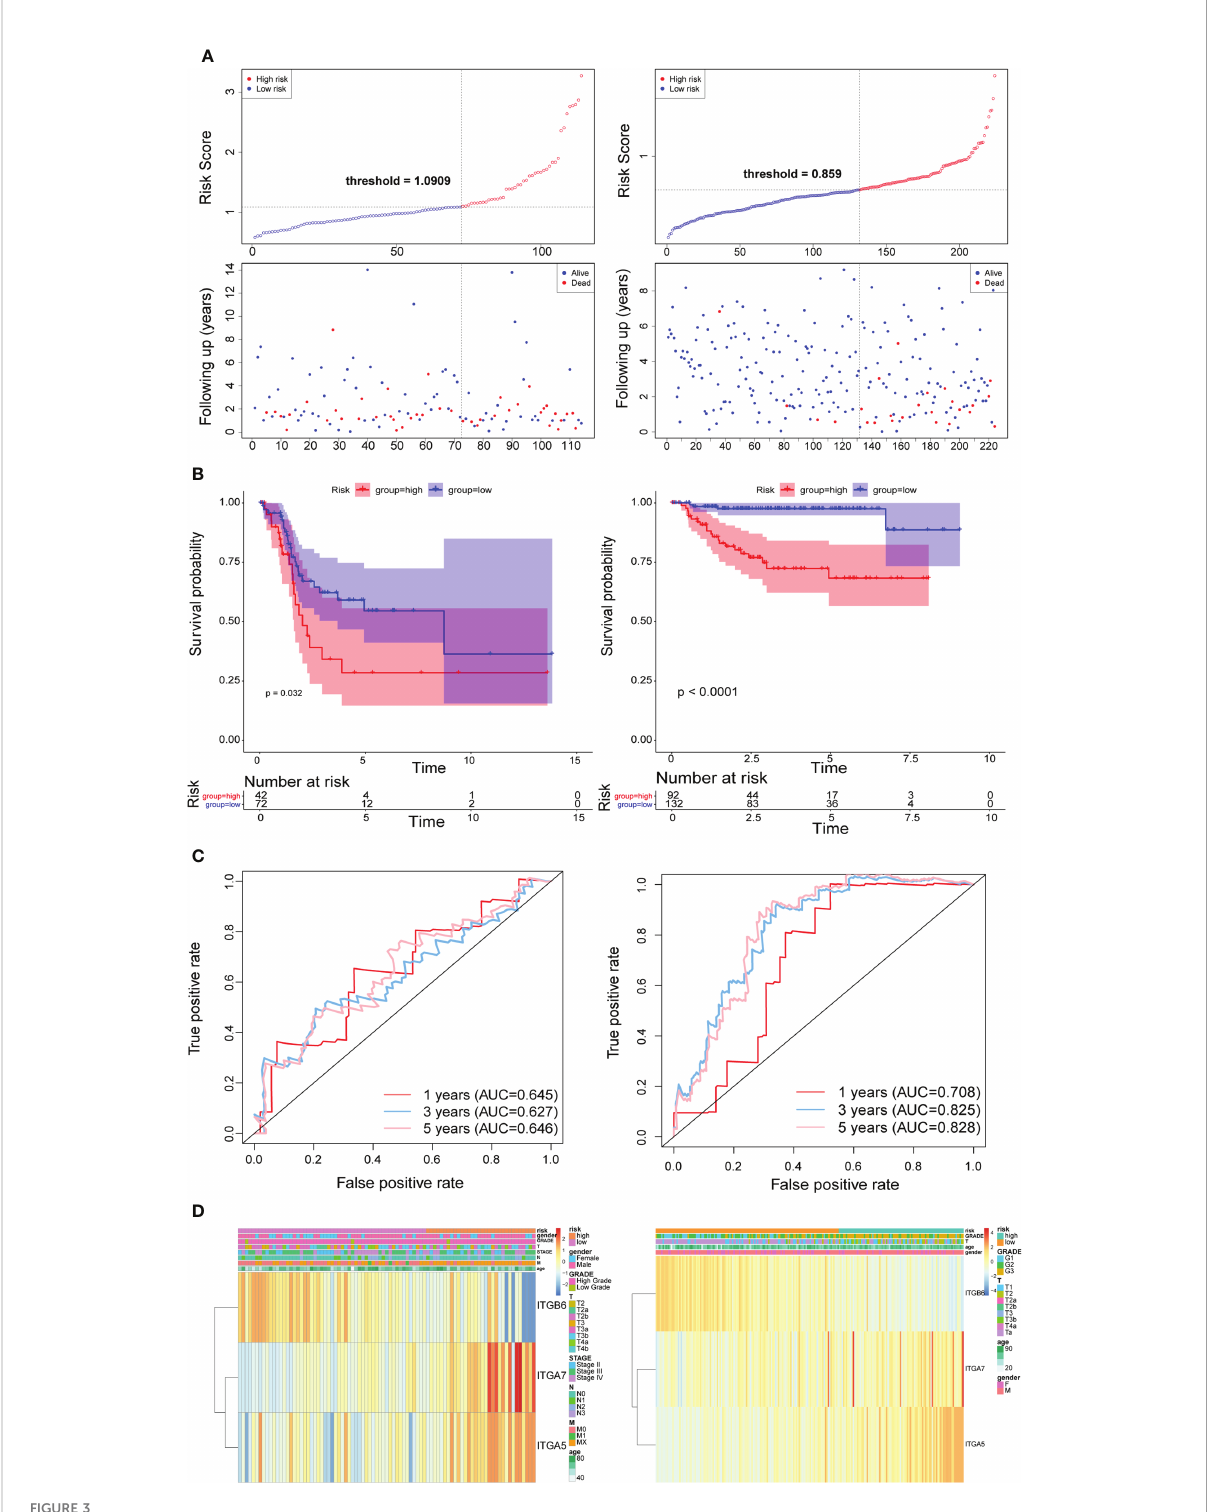
FIGURE 3 Time-dependent ROC analysis, risk score analysis, and Kaplan-Meier analysis for the three characteristics in testing set from TCGA (left) and the validation set from GSE32894 cohort (right). (A) Risk score of three gene signature. (B) Kaplan-Meier curve of the three risk characteratics. (C) ROC curve of the three-gene signature. (D) The heatmap of the three gene characterastics in high- and low-risk groups, the distribution of clinicopathological features was compared between the low- and high-risk